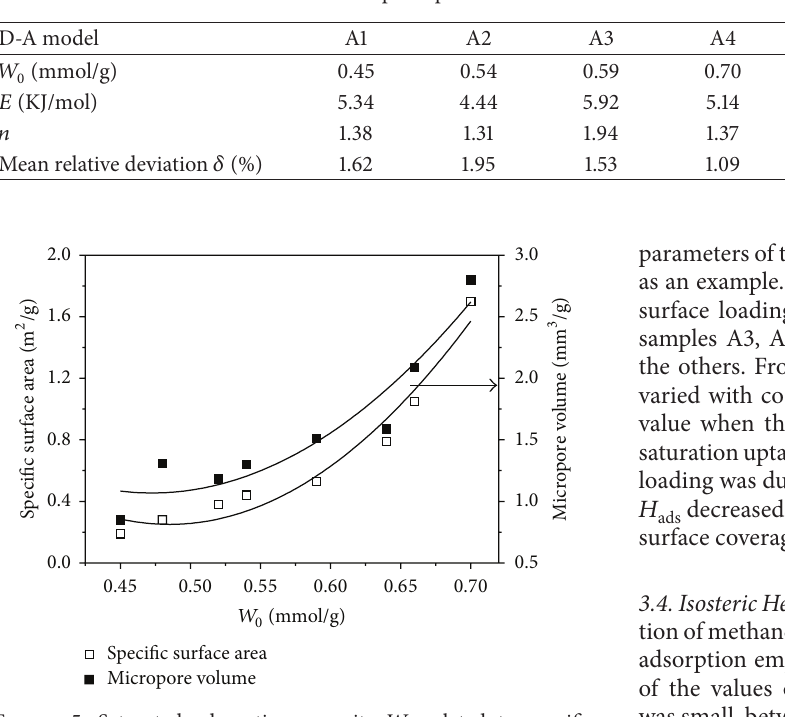
Figure 5: Saturated adsorption capacity 𝑊 0 related to specific surface area ( ◻ ) and micropore volume ( ◼